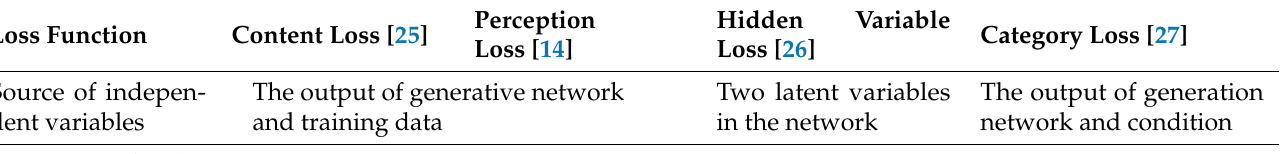
Table 1. The comparison of different loss